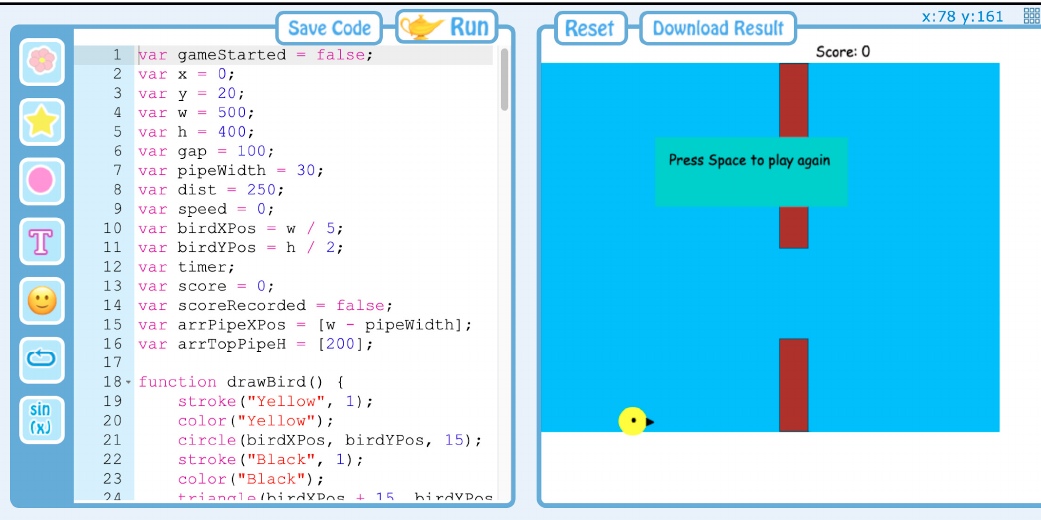
Figure 7. Flappy Bird game in the Code Genie Web IDE.